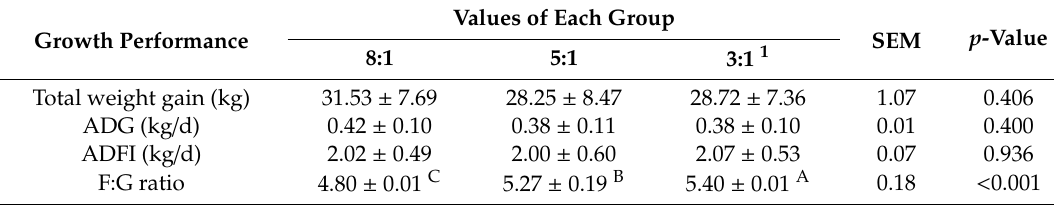
Table 2. E ff ects of dietary n-6 / n-3 polyunsaturated fatty acids (PUFA) ratio on the growth performance of Heigai pigs.